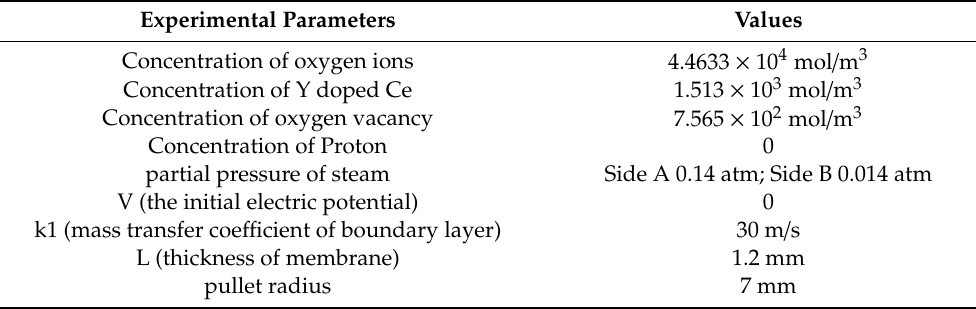
Table 2. The initial parameters of the model in this